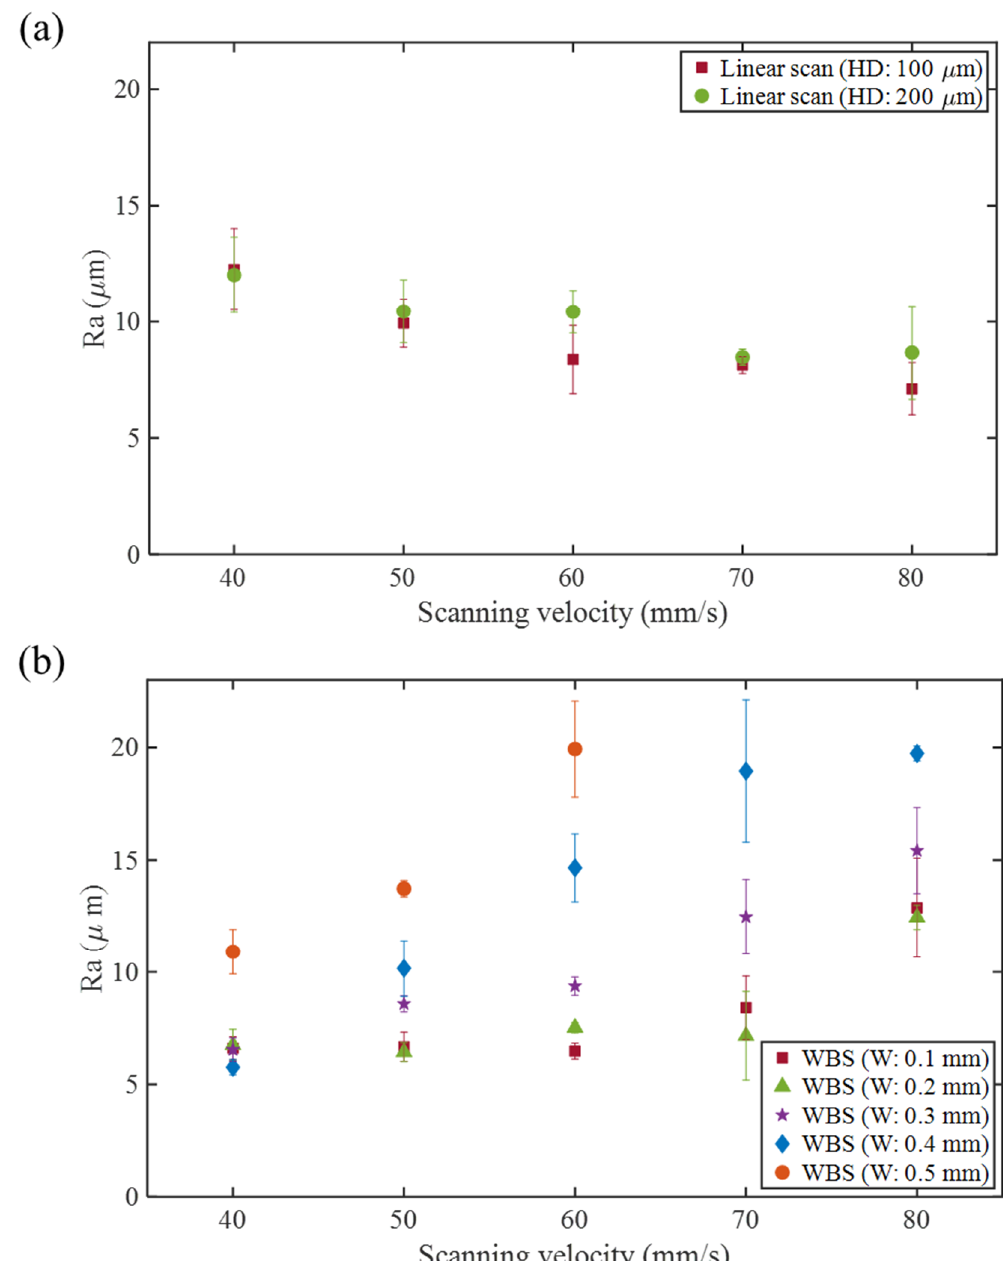
Figure 5. Surface roughness at different scanning speeds: ( a ) LS (HD 100, 200 μm), ( b ) WBS (HD200 μm, 66% OL, W 0.1~0.5 mm).